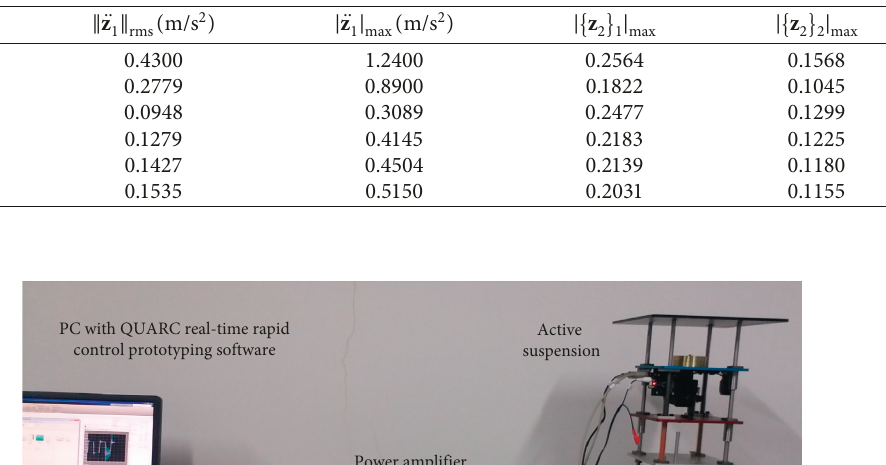
Table 2: Indicators of suspension outputs under random road disturbance.